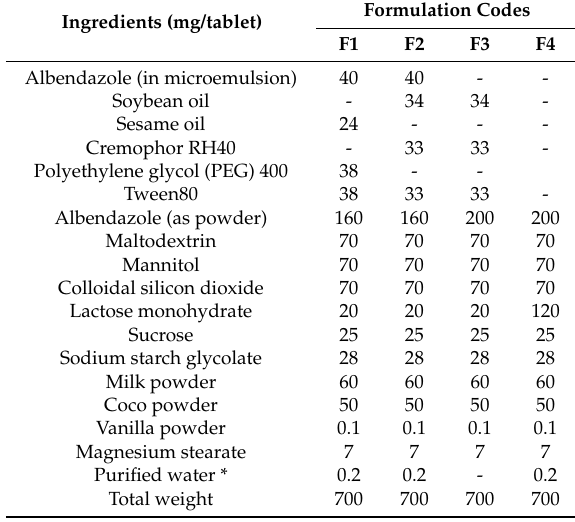
Table 1. Composition of albendazole self-microemulsion chewable tablet